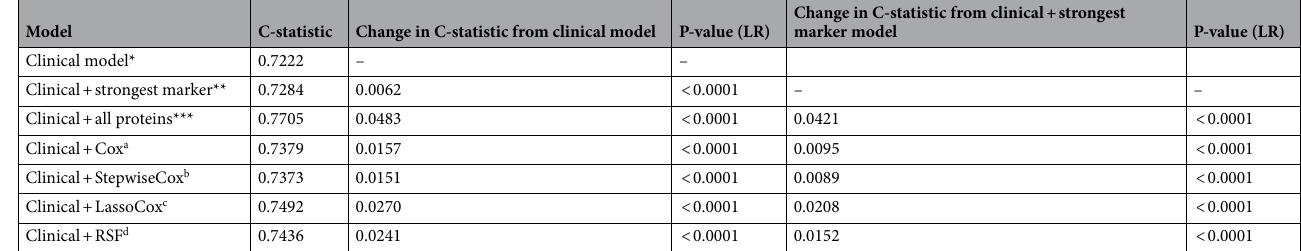
addition, there was a significant improvement in IDI and cNRI for all markers, except for NTproBNP, where no improvement in cNRI was observed (P = 0.12). Selection of multiple predictors using regression‑based methods and RSF.